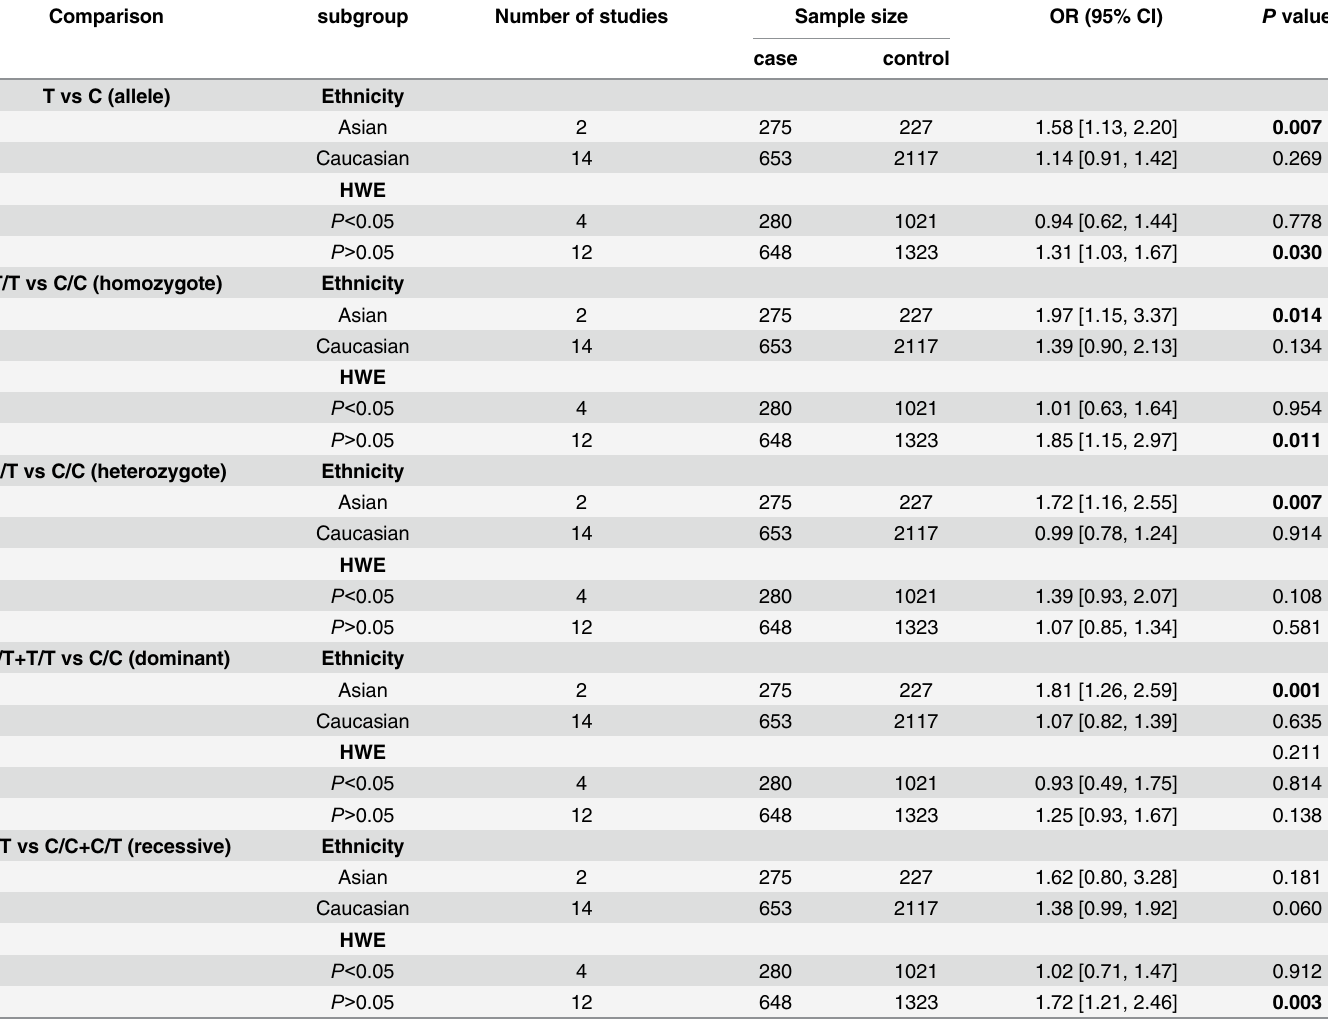
Table 4. Subgroup analysis for the association between MTHFR C677T genotype frequencies and the risks of